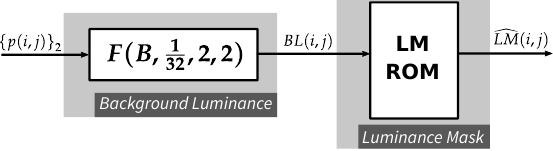
Figure 11. Luminance masking function.